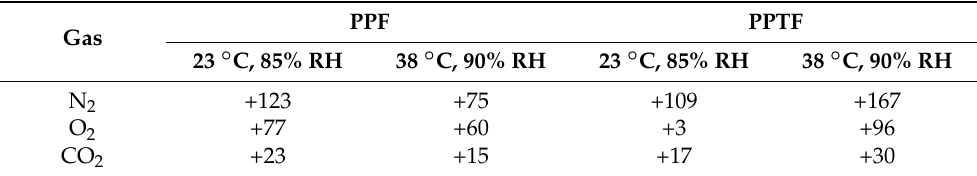
Table 2. Percent of GTR increment at 23 °C and 85% of RH and at 38 °C and 90% of RH.